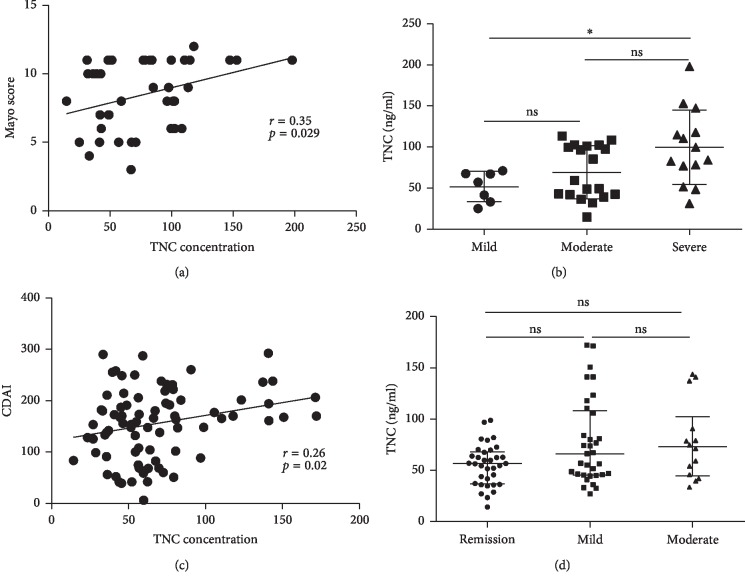
Serum TNC levels and severity of IBD. (a) Correlation between TNC levels and Mayo score in patients with UC; (b) serum TNC levels according to disease severity in patients with UC; (c) correlation between TNC levels and CDAI in patients with CD; (d) serum TNC levels according to disease severity in patients with CD. ∗P < 0.05. UC, ulcerative colitis; CD, Crohn's disease.